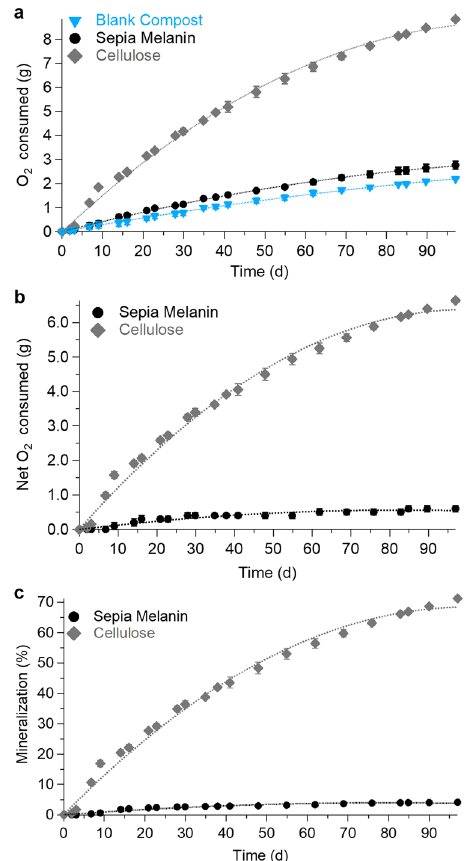
Fig. 2 Biodegradation under mesophilic conditions (25 °C). a Cumulative O 2 consumed: blank compost, Sepia Melanin, and cellulose. b Net O 2 consumed by Sepia Melanin and cellulose, with respect to the O 2 consumption of the blank compost. c Mineralization of Sepia Melanin and cellulose. Error bars = standard deviation ( n = 3 for Sepia Melanin, n = 2 for blank compost and